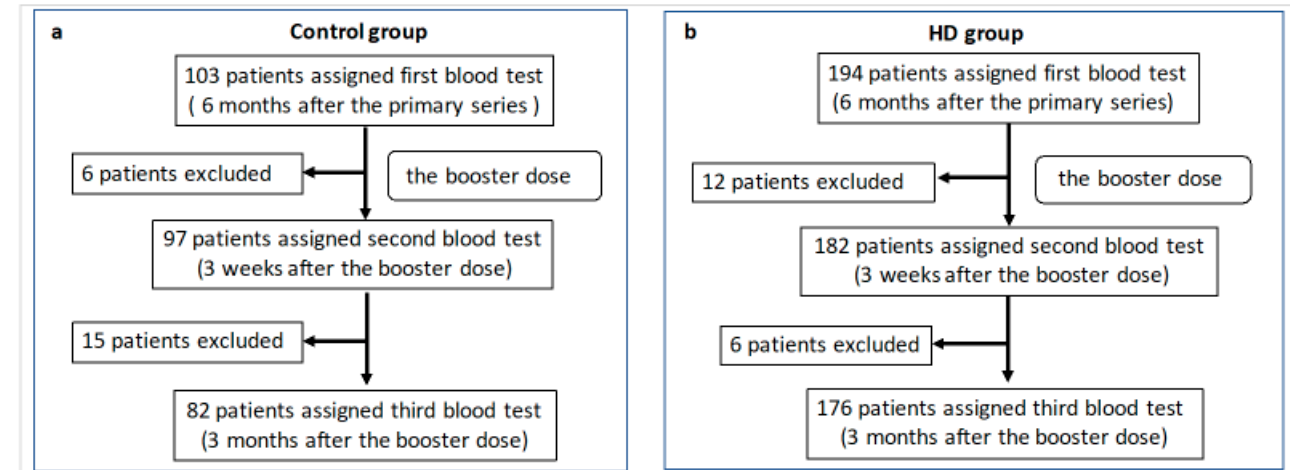
Figure 1. Trial profile. Blood samples were collected from 103 participants in the control group at 6 months after the primary series. Subsequently, one participant moved away, two were infected with severe acute respiratory syndrome coronavirus 2 (SARS-CoV-2), and three refused the booster dose. Therefore, blood samples were collected from the 97 remaining participants at 3 weeks after the booster dose. Thereafter, ten participants moved away or withdrew from the study, three were infected with SARS-CoV-2, and two could not be contacted. Therefore, blood samples were collected from the remaining 82 participants 3 months after the booster dose ( a ). Blood samples were collected from the 194 participants in the hemodialysis (HD) group at 6 months after the primary series. Subsequently, five participants were infected with SARS-CoV-2, two moved away, two died, and three refused booster vaccines. Therefore, blood samples were collected from the remaining 182 participants 3 weeks after the booster dose (3 weeks). Thereafter, four patients were hospitalized, one moved away, and one died. Therefore, blood samples were obtained from the 176